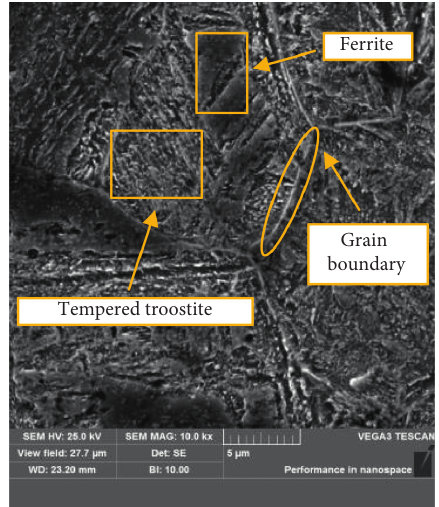
Figure 5: SEM image of tempered structure (10.00 kx).